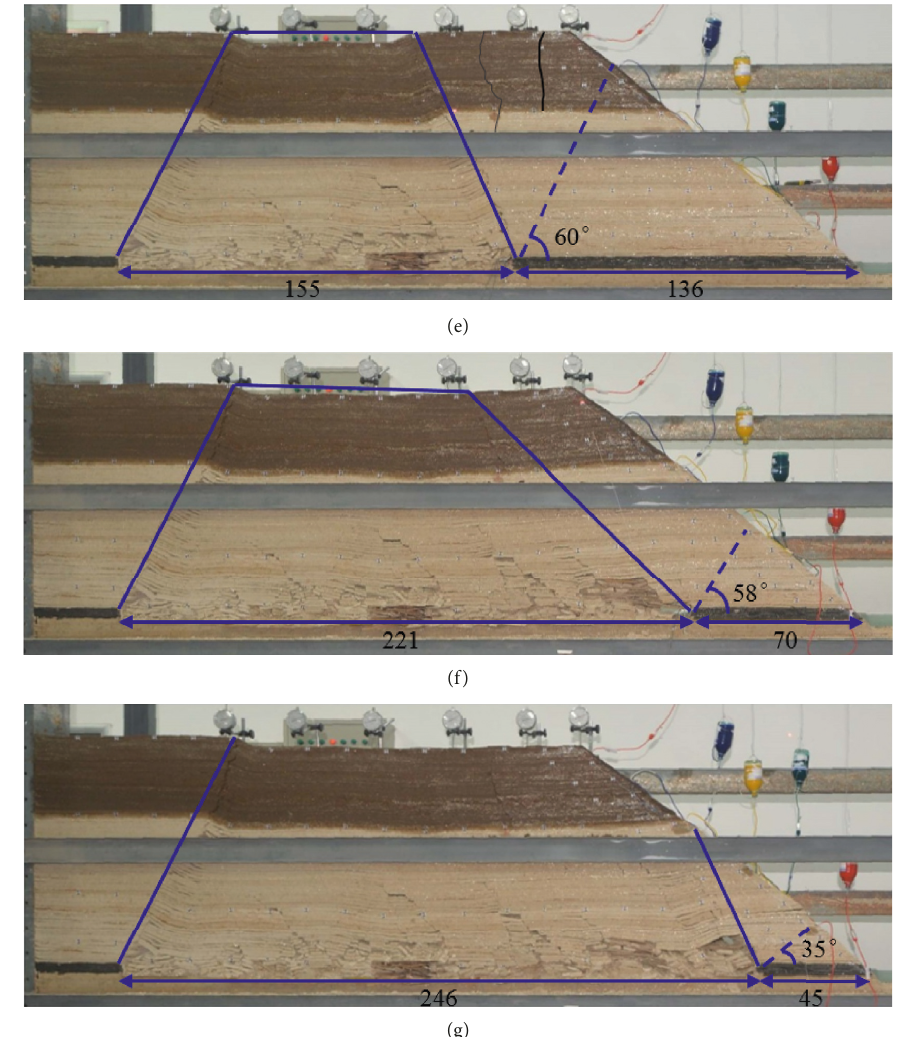
Figure 6: Roof caving when the working face advances to 58cm (a), 99cm (b), 128cm (c), 139cm(d), 155 cm (e), 221 cm (f), and 246cm (g),